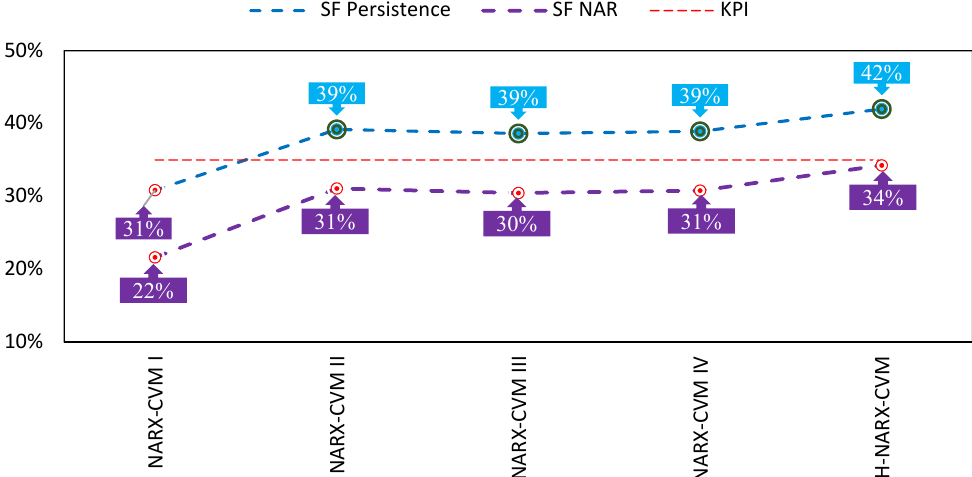
Figure 12. Skill forecasting using a 35% KPI.